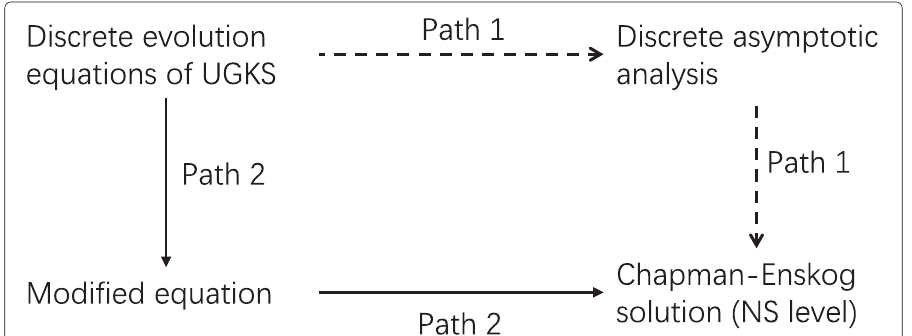
Fig. 4 Two equivalent ways to analyze the multiscale property of UGKS. Path 1 is a direct asymptotic analysis to the discrete UGKS which leads to a discrete Chapman-Enskog expansion [31], and Path 2 follows Guo’s unified preserving analysis